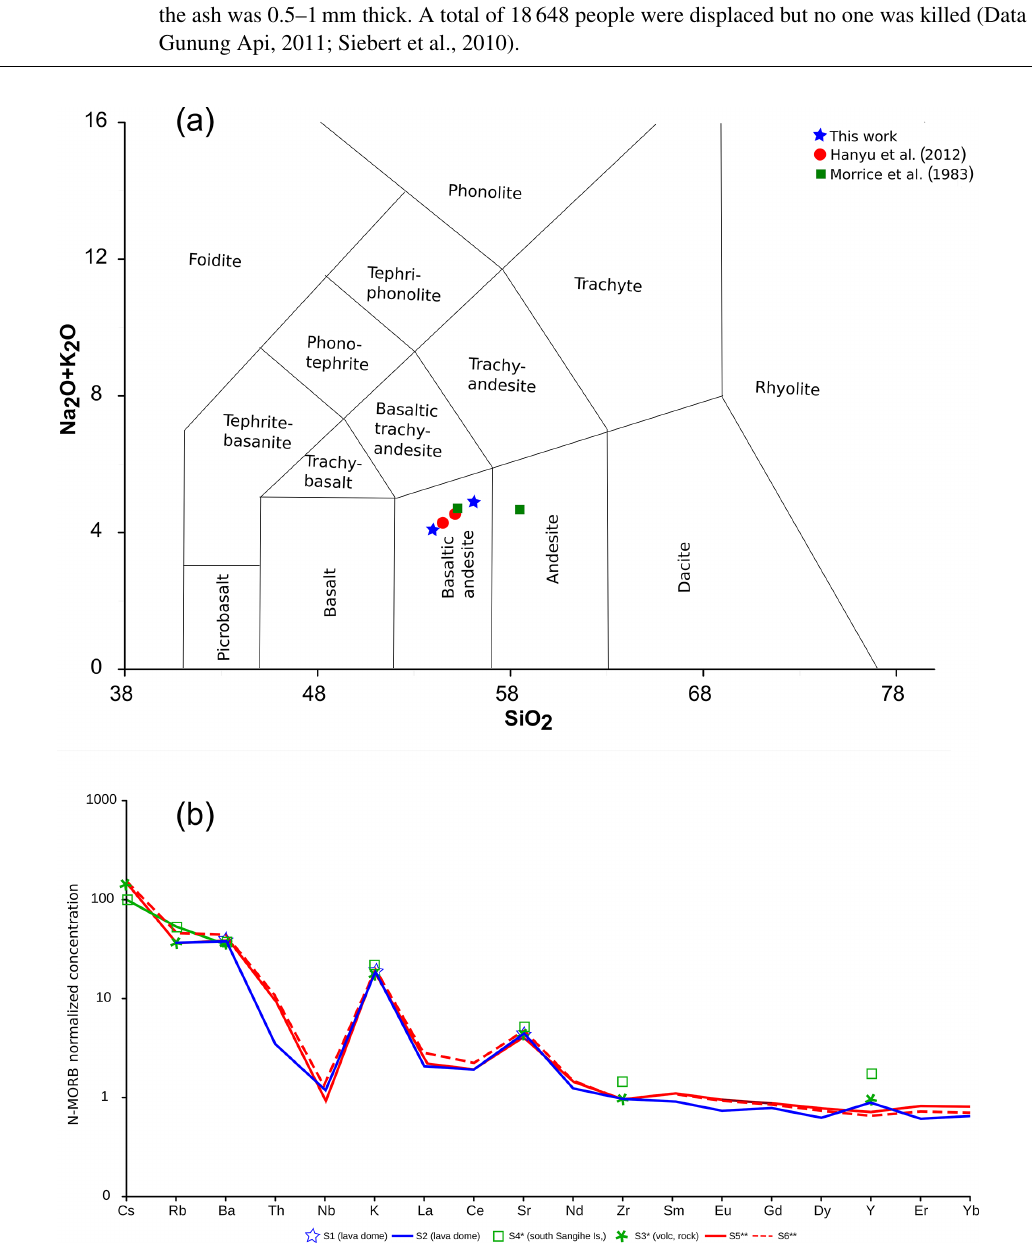
Figure 3. (a) Awu melt source is of basaltic andesite composition. Note that the sample from the southern part of the Sangihe Islands (Morrice et al., 1983) rather indicates an andesite source. (b) Trace elements normalized to N-MORB indicate elevated ratios of LILEs, LREEs, and